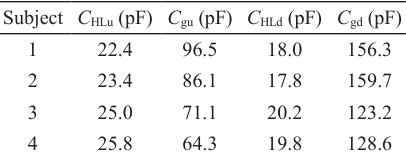
Table 3. Capacitance C HL measured with the MT4080 LCR meter and calculated body capacitance to ground C g for the four subjects and two feet heights above ground: 10 cm (u) and direct outsole contact